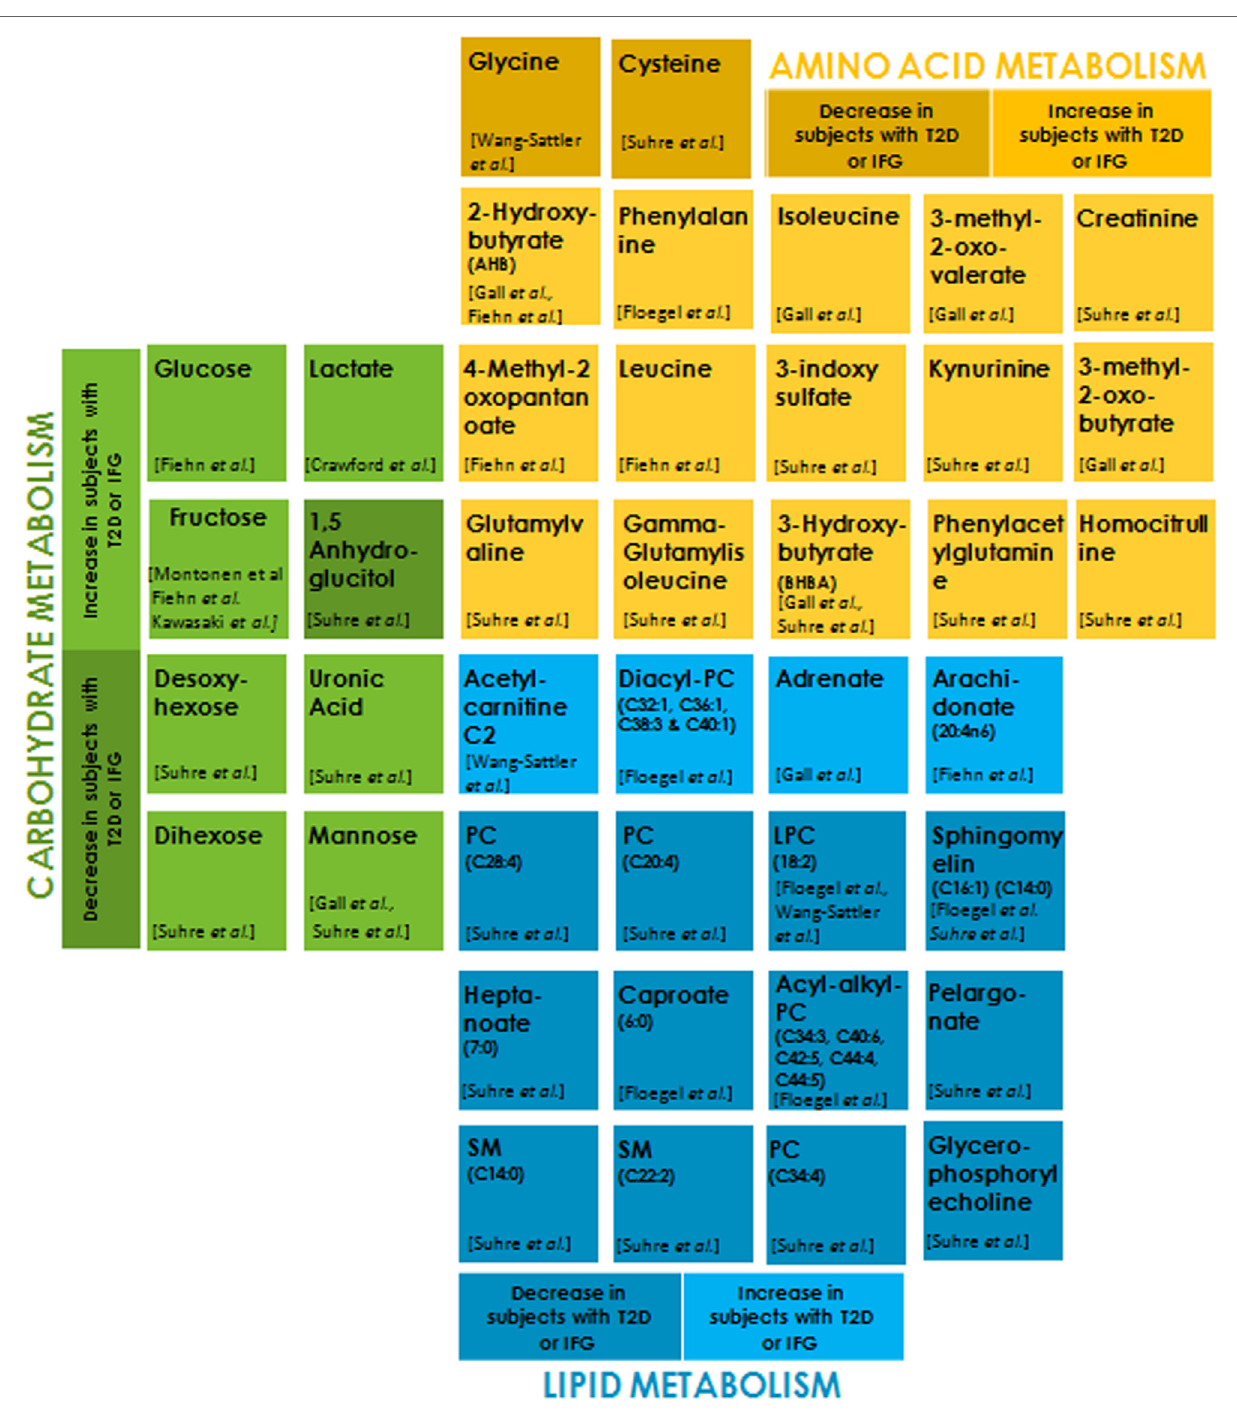
FiGURe 2 | Metabolites belonging to each of the sub groups, i.e., carbohydrate metabolism, amino acid metabolism, and lipid metabolism are differentially color-coded. The light and dark shades of the same color indicate metabolites that are significantly increased and decreased, respectively, in subjects with type 2 diabetes (T2D) or impaired fasting glucose (IFG) with respect to normoglycemic control subjects ( p < 0.01–0.0001).